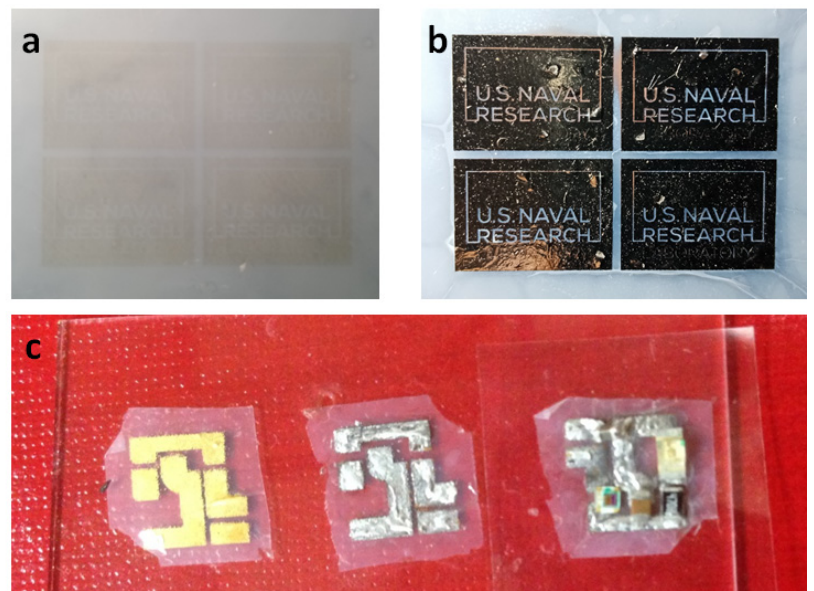
Figure 2. ( a ) Ink-jet printed NRL (U.S. Naval Research Laboratory) logo on nanocellulose with a palladium-based catalyst ink. ( b ) Electroless copper-then-nickel-plated NRL logo on nanocellulose, based on the ink pattern in ( a ). ( c ) Soldering process on a nanocellulose printed circuit board (PCB). Left: A nanocellulose sheet with an electroless-plated wiring pattern of gold-plated, nickel-plated copper. Middle: A similar pattern with Field’s Metal soldered onto the surface. Right: Electronic components mounted onto the soldered wiring pattern.